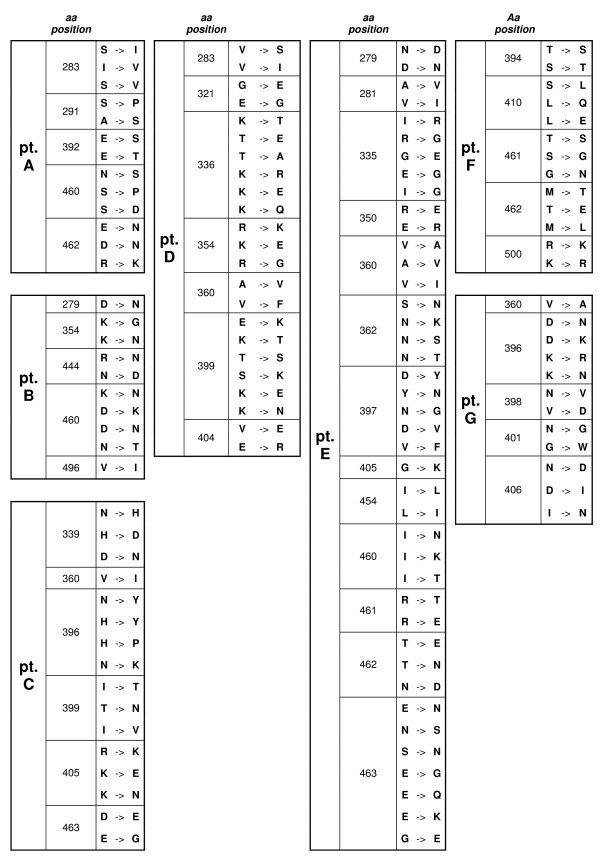
Positively selected sites identified along internal branches. Amino acid (aa) positions are indicated according to HXB2 sequence.